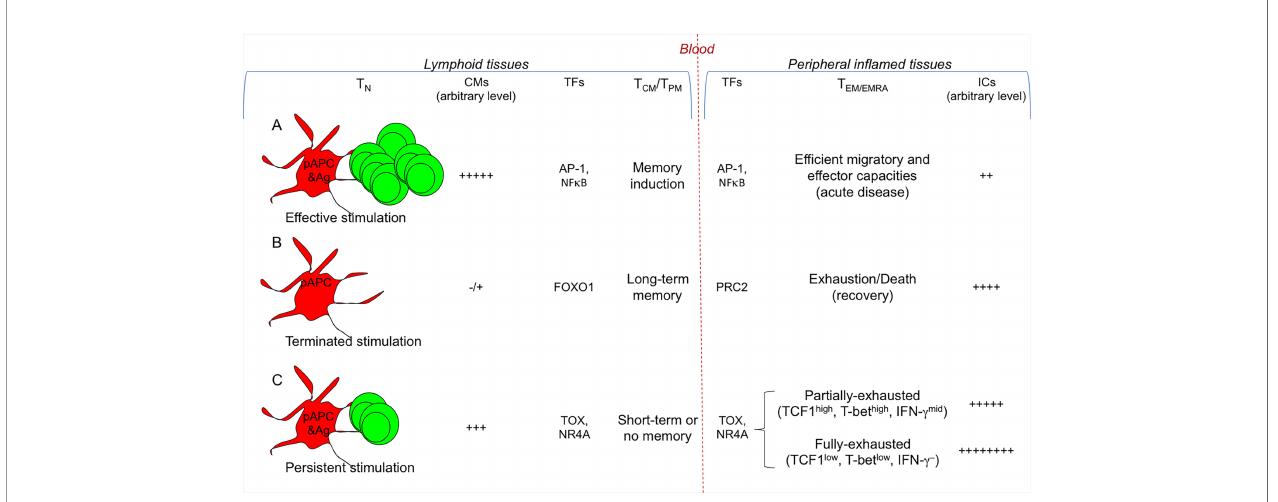
FIGURE 2 | Signals conditioning T cell diversi fi cation. Different strengths of T cell stimulation result in different fates. The most relevant TFs involved are indicated. (A) Ef fi cient and transient antigenic and co-stimulatory molecule (CM) signals by pAPCs condition strong T cell proliferation and differentiation into memory T cells (T CM /T PM ) and the various types of T EM/EMRA cell subsets (Th/c1, Th/c2, Th/c17, … ), selected according to the cytokine milieu in which the response takes place (see Figure 1 ). TFs (e.g., AP-1, NF k B) activate memory (e.g., IL7R , BCL2 ) and effector genes (e.g., IFNG , GZMB ). (B) Under these conditions, the T cell response generally results with the eradication of a given pathogen and recovery: the combination of termination of antigen exposure and upregulation of ICs on T EM/EMRA cells will lead to their drastic decrease and death, whereas memory cells will persist without the presence of antigen, and will provide long-term memory. TFs such as FOXO1 maintain long-term memory, whereas PRC2 contributes in silencing effector genes. (C) In the presence of persistent antigen-stimulation (e.g., chronic infections or tumors), the continuous viral or tumor mutations will induce the generation of continuous waves of T cells, which, because chronically exposed to antigen-stimulation, will upregulate a wide repertoire of ICs, and will undergo chronic T cell exhaustion resulting in the lack of (long-term) immunological memory. TFs (e.g., TOX, NR4A) favor the transcription of exhaustion genes (e.g., encoding PD-1, TIM-3, CTLA-4), overwhelming the work of those (e.g., AP-1, NF k B) activating effector genes (e.g., IFNG , GZMB ) or memory genes (e.g., IL7R , BCL2 ). In the early phase of the persistent antigen-stimulation, T EM/EMRA cells will become partially- exhausted (TCF1 high , T-bet hgh , IFN- g mid ), then they will degenerate in fully-exhausted cells (TCF1 low , T-bet low , IFN- g – ) and will further upregulate ICs. Partially- exhausted T cells can be rescued by